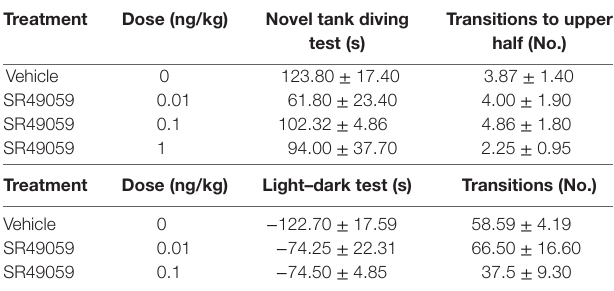
Mean values ± SEM (n = 10 for each